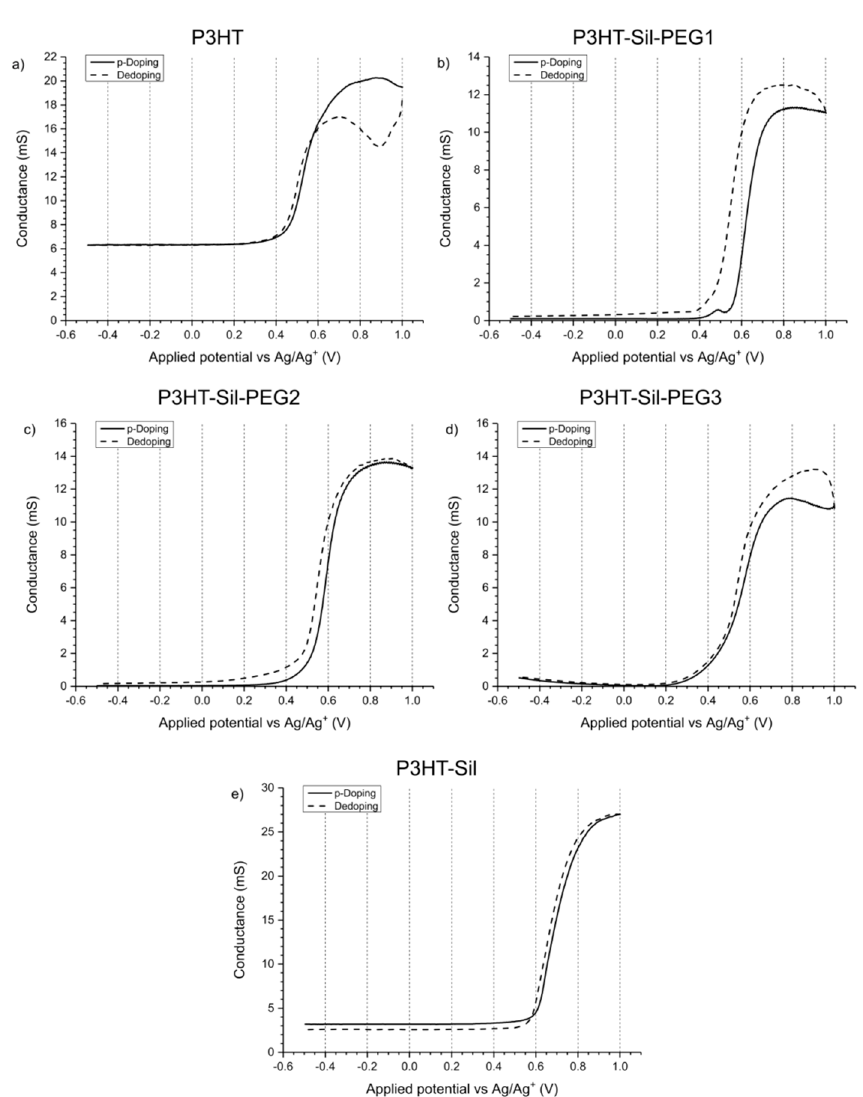
Figure 10. Double working electrode electroconductometry of ( a ) regioregular P3HT; ( b ) P3HT-Sil-PEG1; ( c ) P3HT-Sil-PEG2; ( d ) P3HT-Sil-PEG3; ( e ) P3HT-Sil films on an interdigitated Pt electrode. Potential offset between the working electrodes Δ V = 0.005 V.